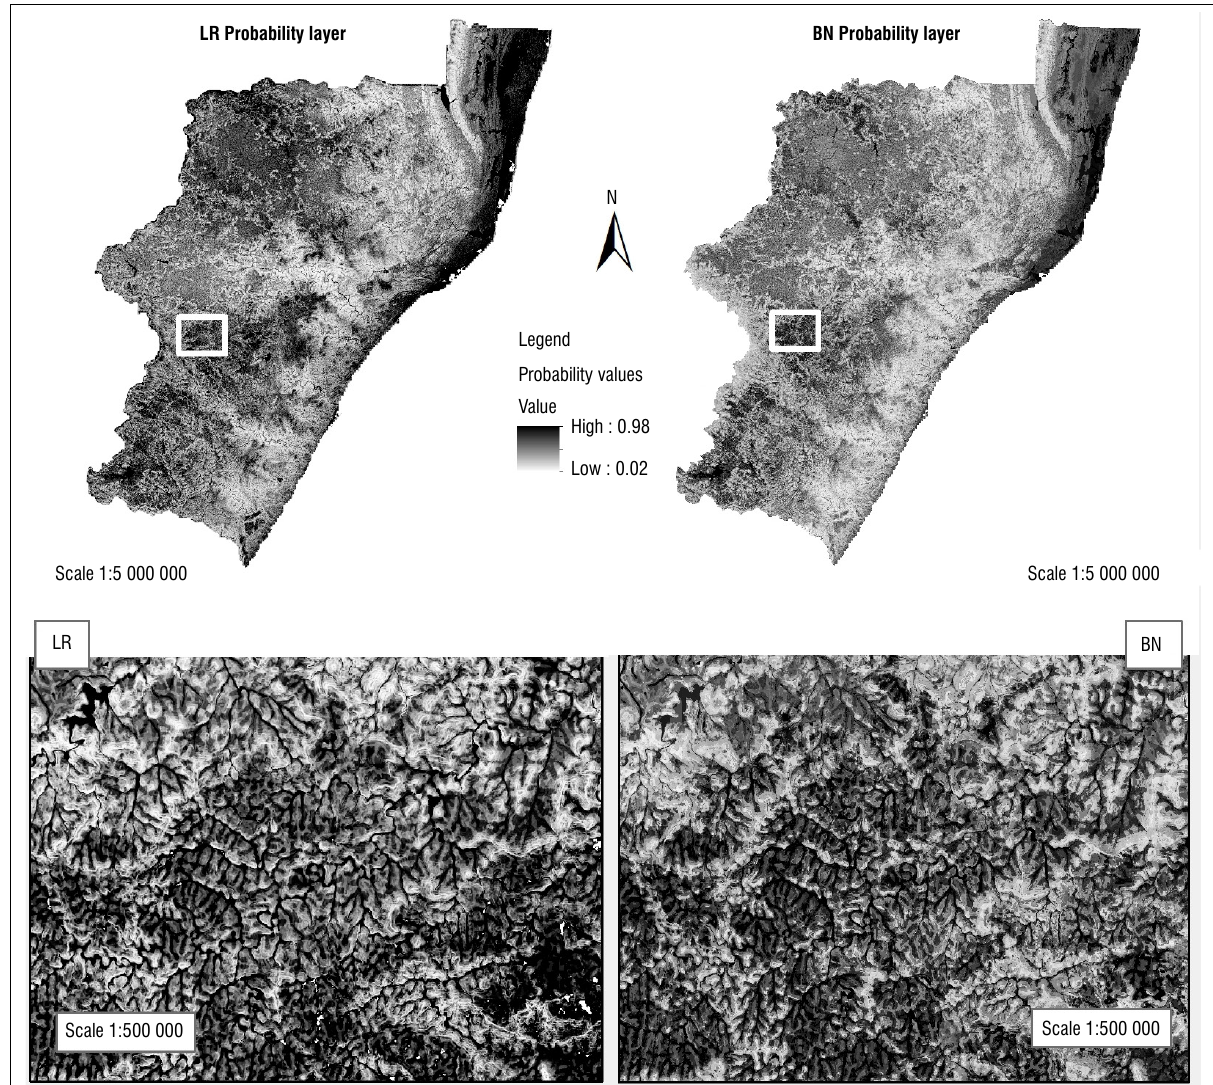
Figure 4: Comparison of the logistic regression (LR) and Bayesian network (BN) probability outputs ranging in scale from 1:5 000 000 (top) to 1:500 000 (bottom). Pixel values range from 0.02 to 0.98, in which the higher the probability values of a pixel, the greater the likelihood of wetland